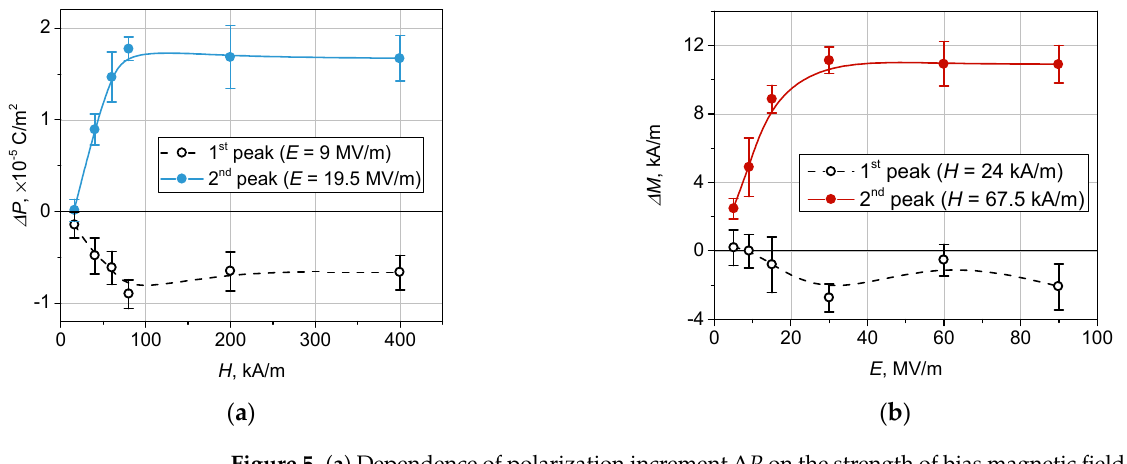
Figure 5. ( a ) Dependence of polarization increment Δ𝑃 on the strength of bias magnetic field strength; ( b ) dependence of magnetization increment Δ𝑀 on the strength of bias electric field.